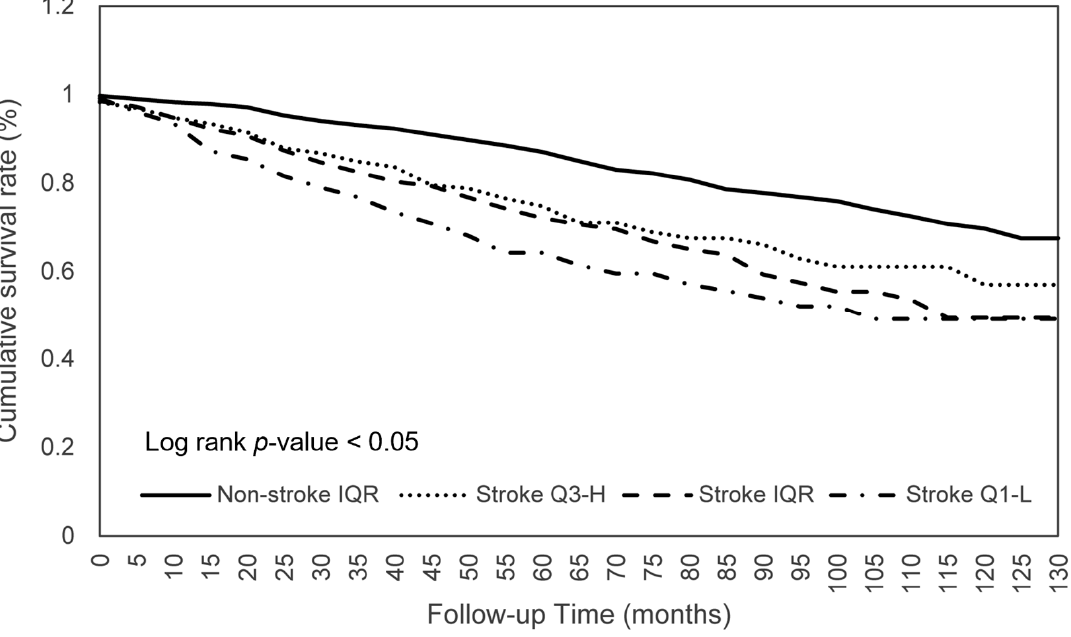
Figure 1. Calorie consumption in relation to the cumulative mortality rates. Abbreviations: Q1-L, Q1-lowest; IQR, interquartile range; Q3-H, Q3-highest.